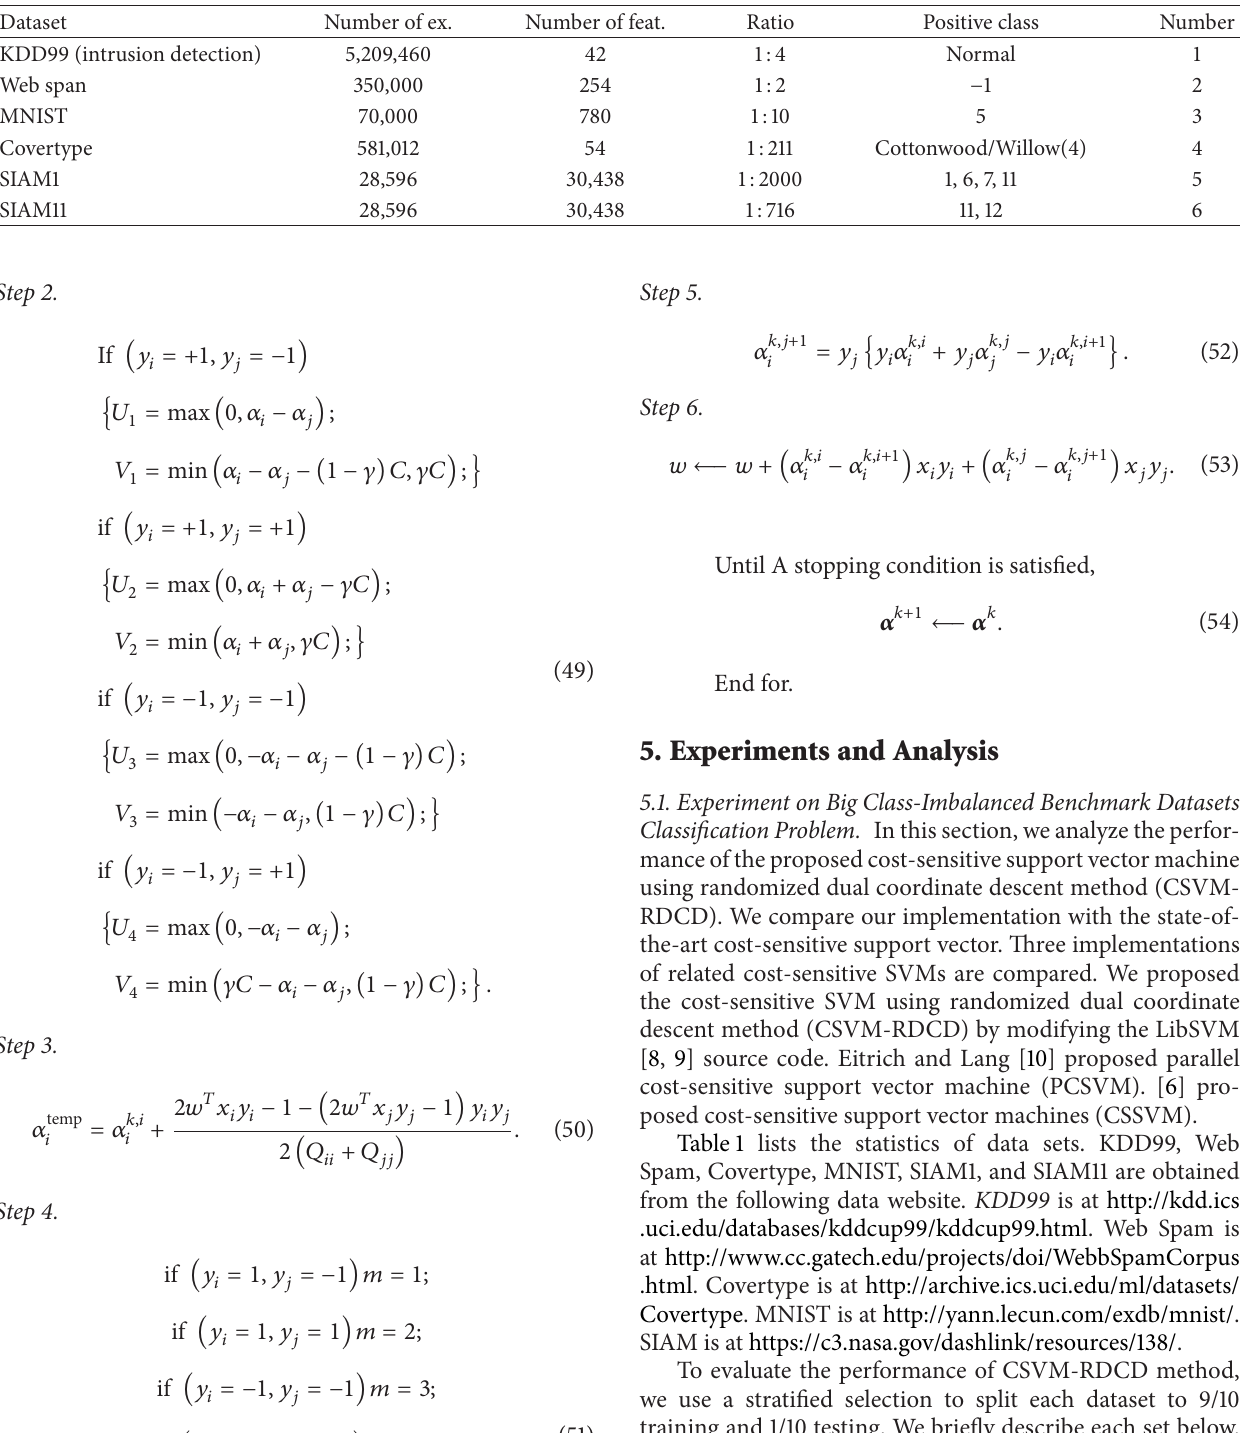
Table 1: Specification of the benchmark datasets. Number of ex. is the number of example data points. Number of feat. is the number of features. Ratio is the class imbalance ratio. Target specifies the target or positive class. Number is the number of the